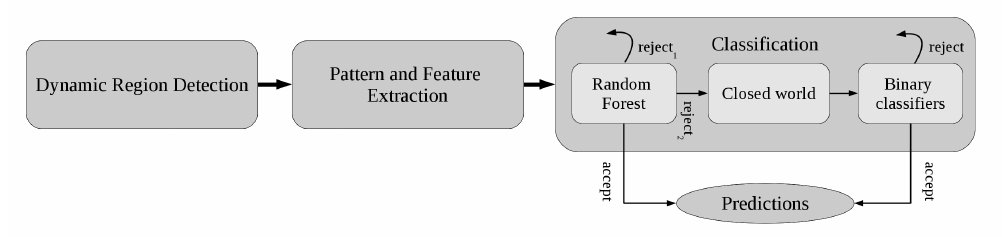
Figure 2. Flowchart of the activity recognition